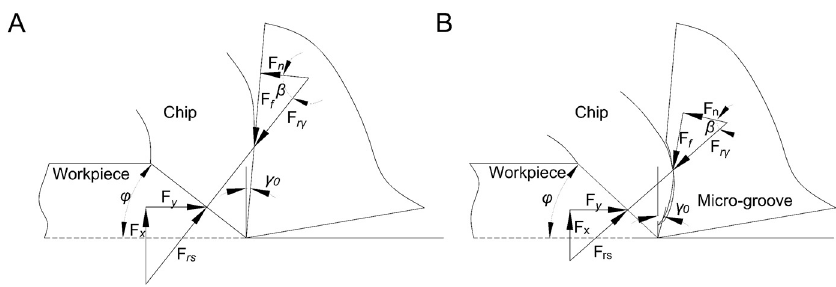
Figure 3. Tool force balance relationship in two-dimensional cutting. ( A ) Tool A. ( B ) Tool B.